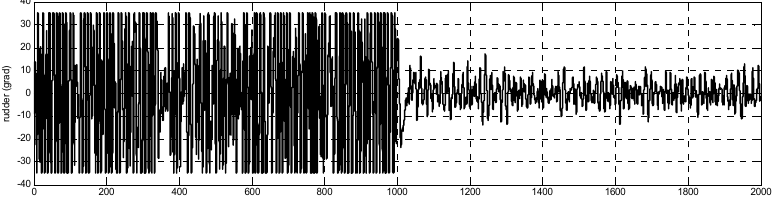
Figure 11. Graph of the function δ ( t ) for the real closed-loop system (23), (30), (31) in Regime 3 of motion.